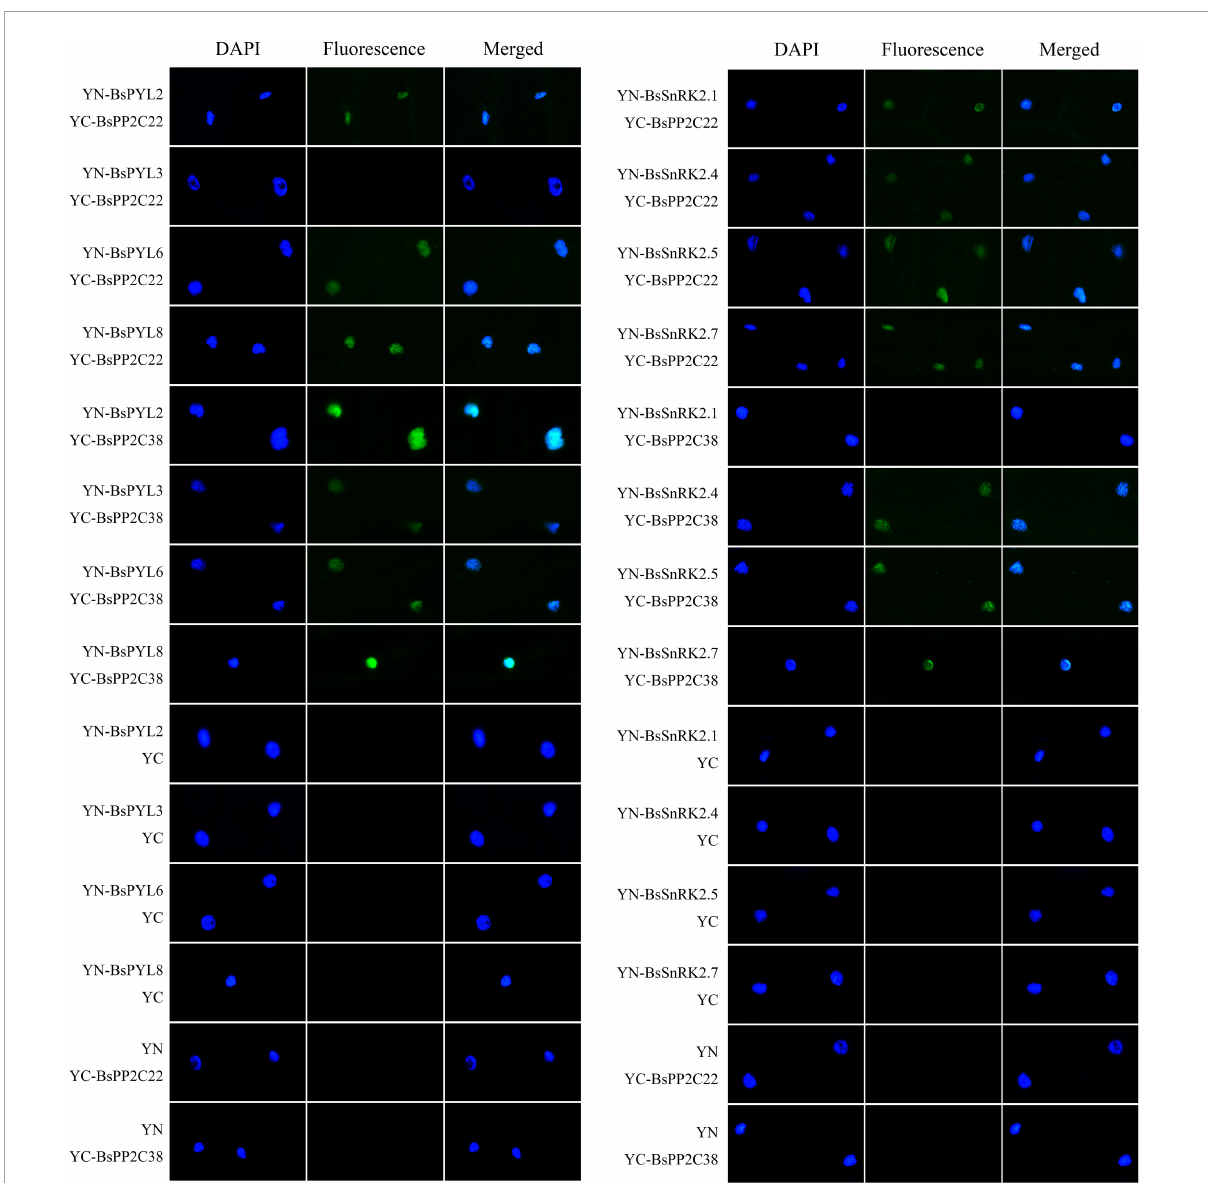
FIGURE9 Bimolecular fluorescent complementation (BiFC) experiments in onion epidermal cells to test the interactions between BsPP2C22 (BsPP2C38) and BsPYLs, as well as between BsPP2C22 (BsPP2C38) and BsSnRK2s. BsPP2C22 (BsPP2C38) was fused with the C-terminal of fluorescein (YC). BsPYLs and BsSnRK2s were fused with the N-terminal of fluorescein (YN). Green fluorescence was observed at ∼ 475 nm, and DAPI was observed at ∼ 350